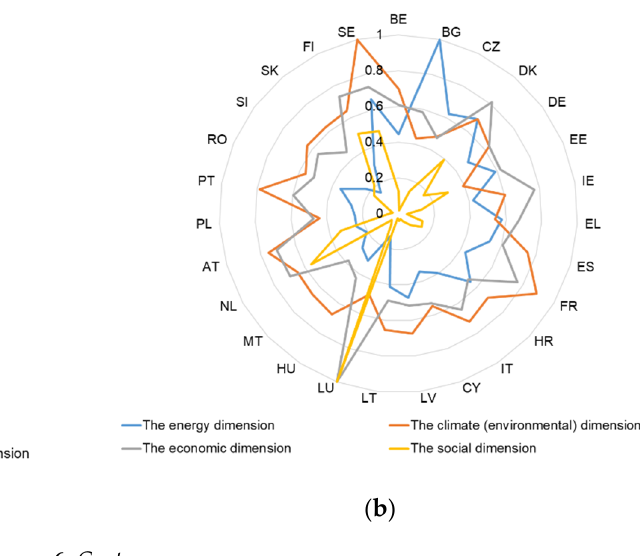
Figure 5. The average value of the P i index for individual EU-27 countries and for the entire study period ( a ) and the division of countries into similar groups ( b